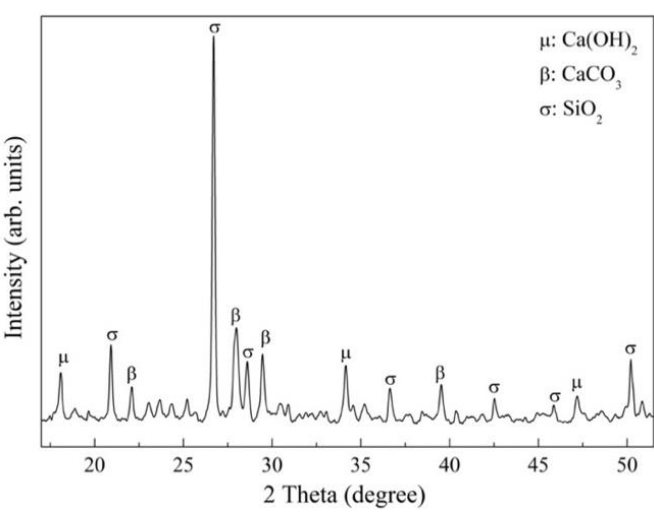
Figure 2. Micrographs of RFA.